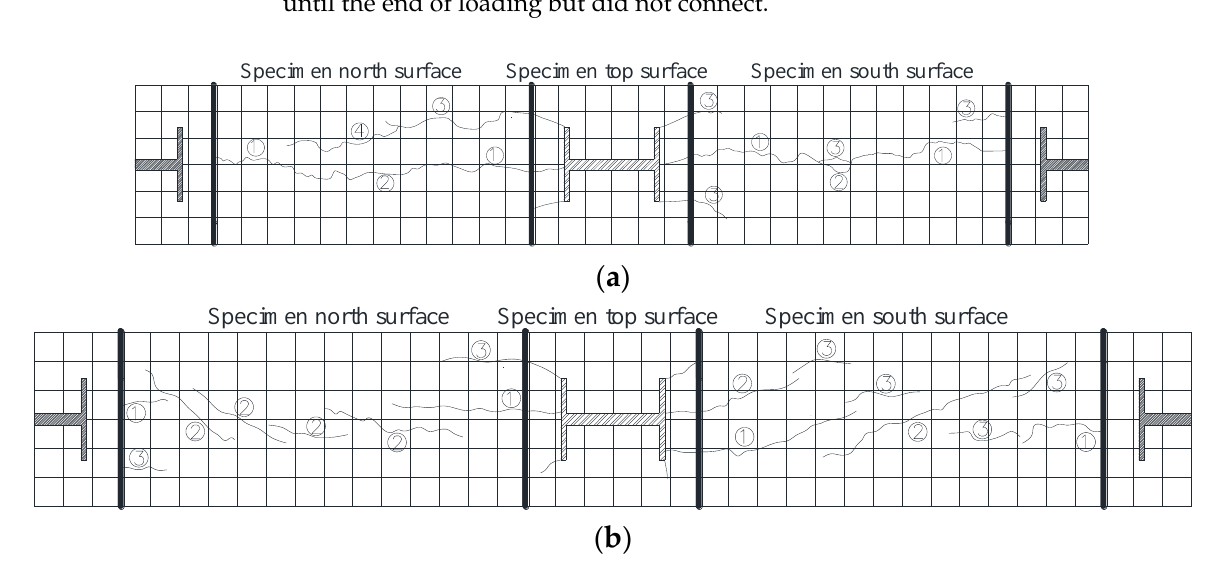
Figure 9. Typical side cracks in the specimens. ( a ) S-SFRAC15. ( b ) S-SFRAC08.